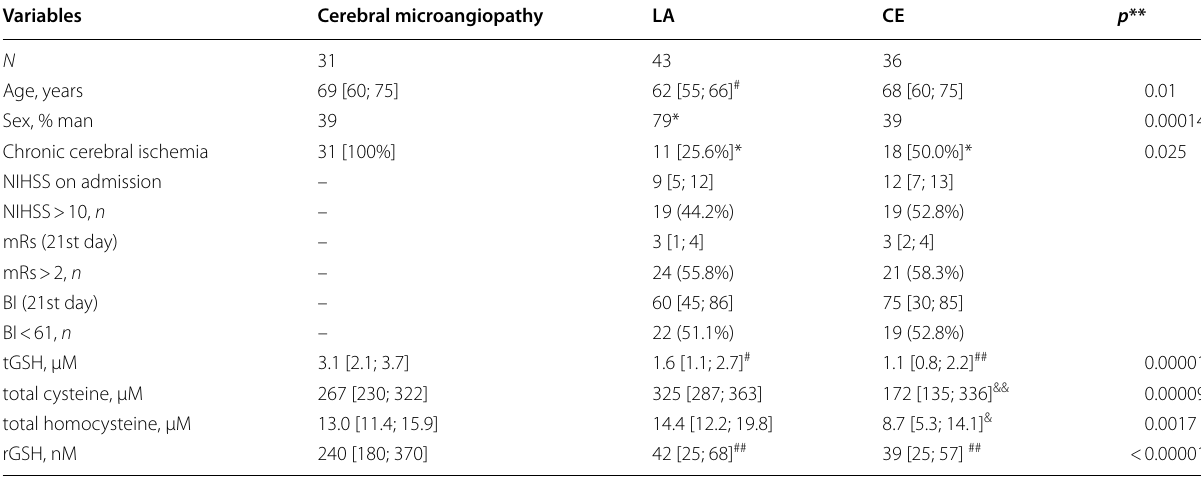
All values represented as median [Q1;